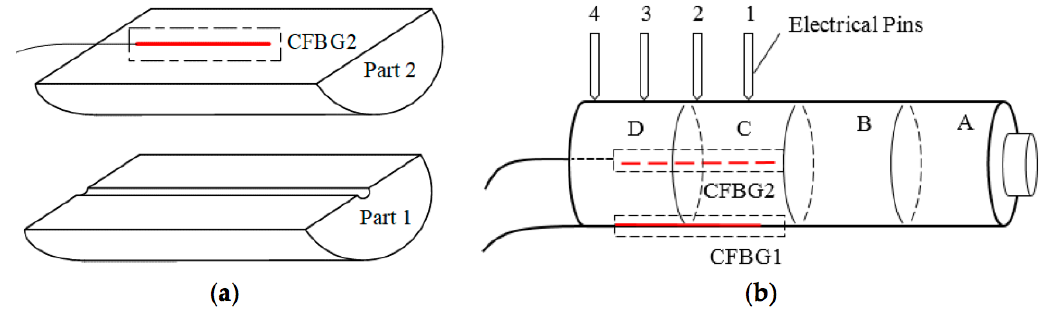
Figure 12. Schematic of the CFBG assembly proposed by Wei et al. ( a ) Assembly of top and bottom parts of the probe; ( b ) structure of the whole sensing probe, inclusive of reference pins. Image from [34].